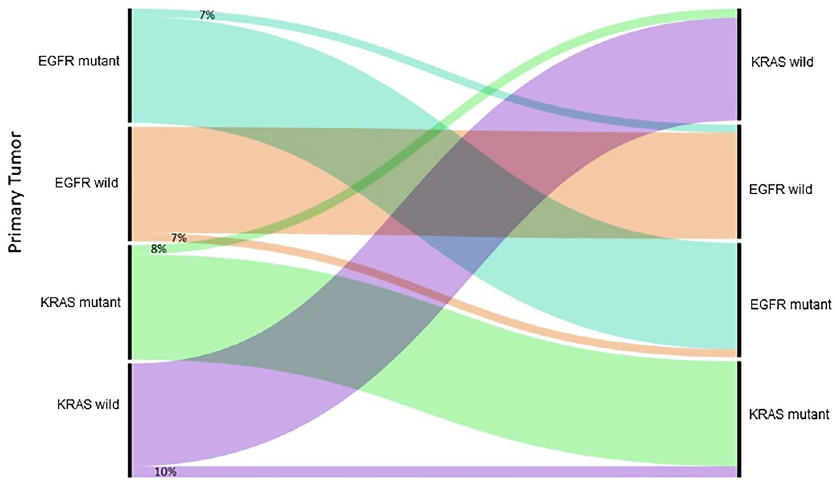
Fig. 3 Alluvial diagram rep- resenting the receptor switch in EGFR and KRAS mutation between primary lung tumor and brain